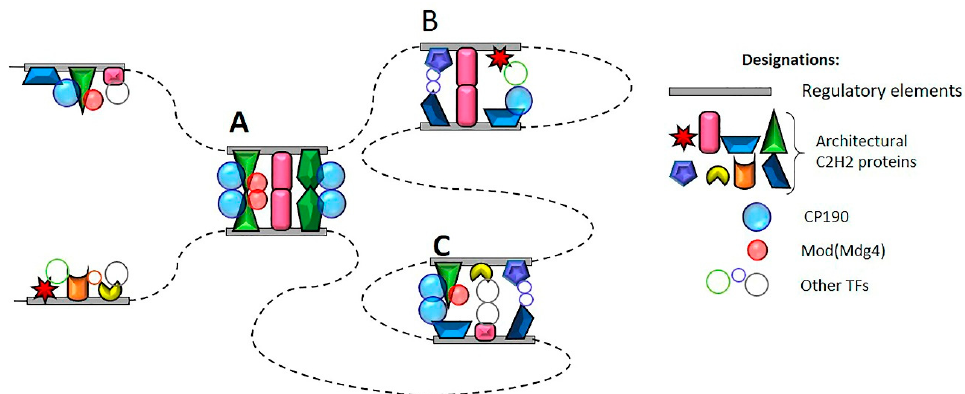
Figure 5. Model of interaction between regulatory elements in Drosophila. Architectural C2H2 proteins bind in different combinations to regulatory elements (promoters, enhancers, insulators). The CP190 and Mod(mdg4) and other similar proteins with homodimerization domains are recruited on the regulatory elements through interaction with C2H2 proteins. ( A ) Super-long-distance interactions are supported by multiple interactions between 3–6 C2H2 proteins associated with the same or structurally similar insulators. The interactions between proteins like Mod(mdg4) and CP190 can play a role in maintaining of stable interaction. ( B ) Specific distance interactions (5–20 kb) can be supported by regulatory elements that contain only partially similar combinations of C2H2 proteins. The auxiliary CP190 and Mod(mdg4) can play an important role in maintaining remote communications in such cases. ( C ) Local interactions between regulatory elements can be supported by proteins such as CP190 and Mod(mdg4), which can be recruited to completely different combinations of C2H2